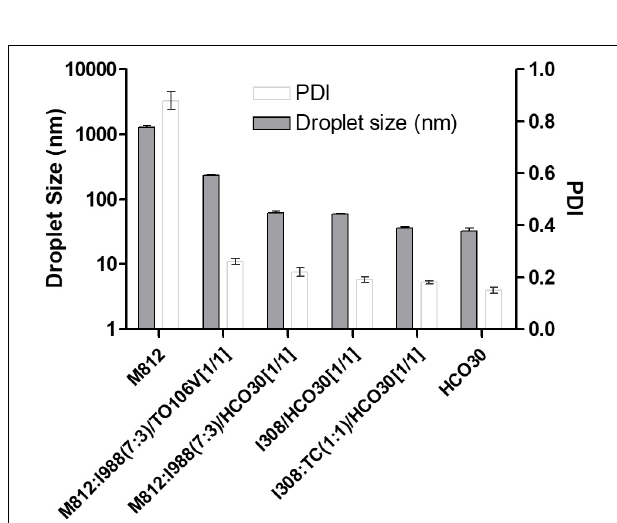
FIGURE 2 | Typical physical appearance of the “Formulations” (F) and the “Alternative Formulations” (AF) after immediate aqueous dispersion with water. The samples used in the experiment were aqueous dispersions of the “drug loaded” formulations.